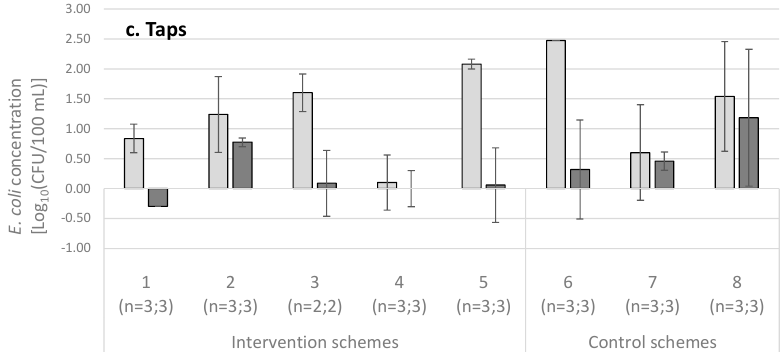
Figure 5. Mean E. coli concentrations of the ( a ) household stored water containers, ( b ) reservoir tanks, and ( c ) taps at the baseline and endline for each of the eight schemes. The standard deviation bars are shown.